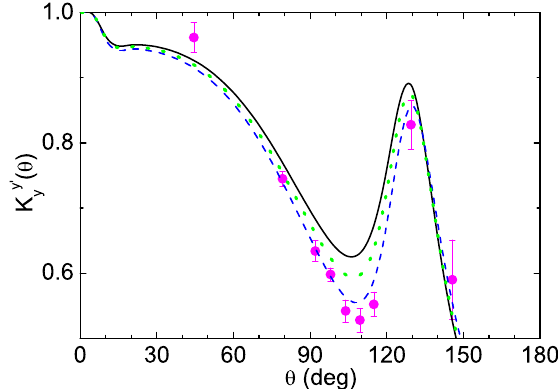
Fig. 2. Nucleon-to-nucleon polarization transfer coe ffi cient ′ K y y ( θ ) of the pd elastic scattering at E p (black) curve denotes the calculation with AV18, the dashed (blue) curve that with AV18 + BR 660 , and the dotted (green) curve that with AV18 + BR 800 + V phe . Experimental data are taken from Ref. [13].